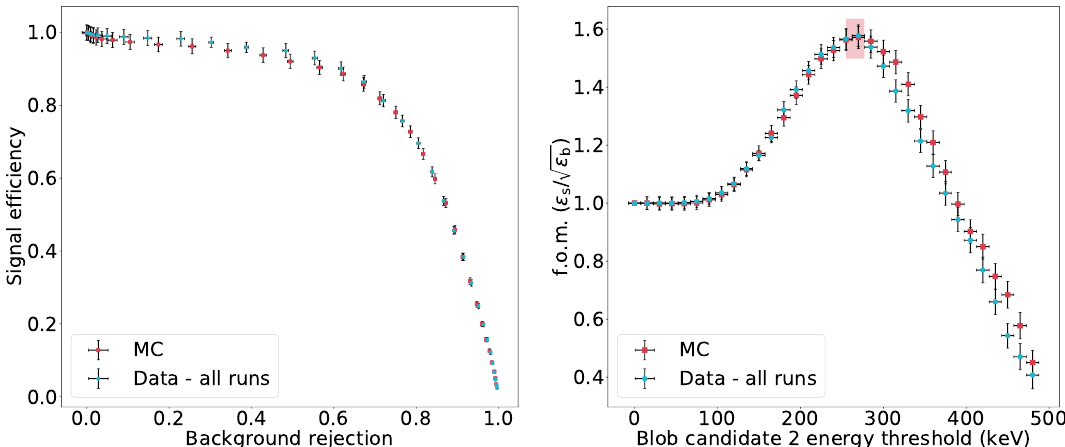
Figure 9 . Left: signal e(cid:14)ciency as a function of background rejection (proportion of background events removed from the sample by the blob cut), varying the required minimum energy of the blob candidate 2 . Right: (cid:12)gure of merit (de(cid:12)ned in eq. 4.1) as a function of the threshold on the energy of the blob candidate 2 after rescaling Monte Carlo. The highlighted area corresponds to the best threshold. In both (cid:12)gures, data and Monte Carlo simulation are